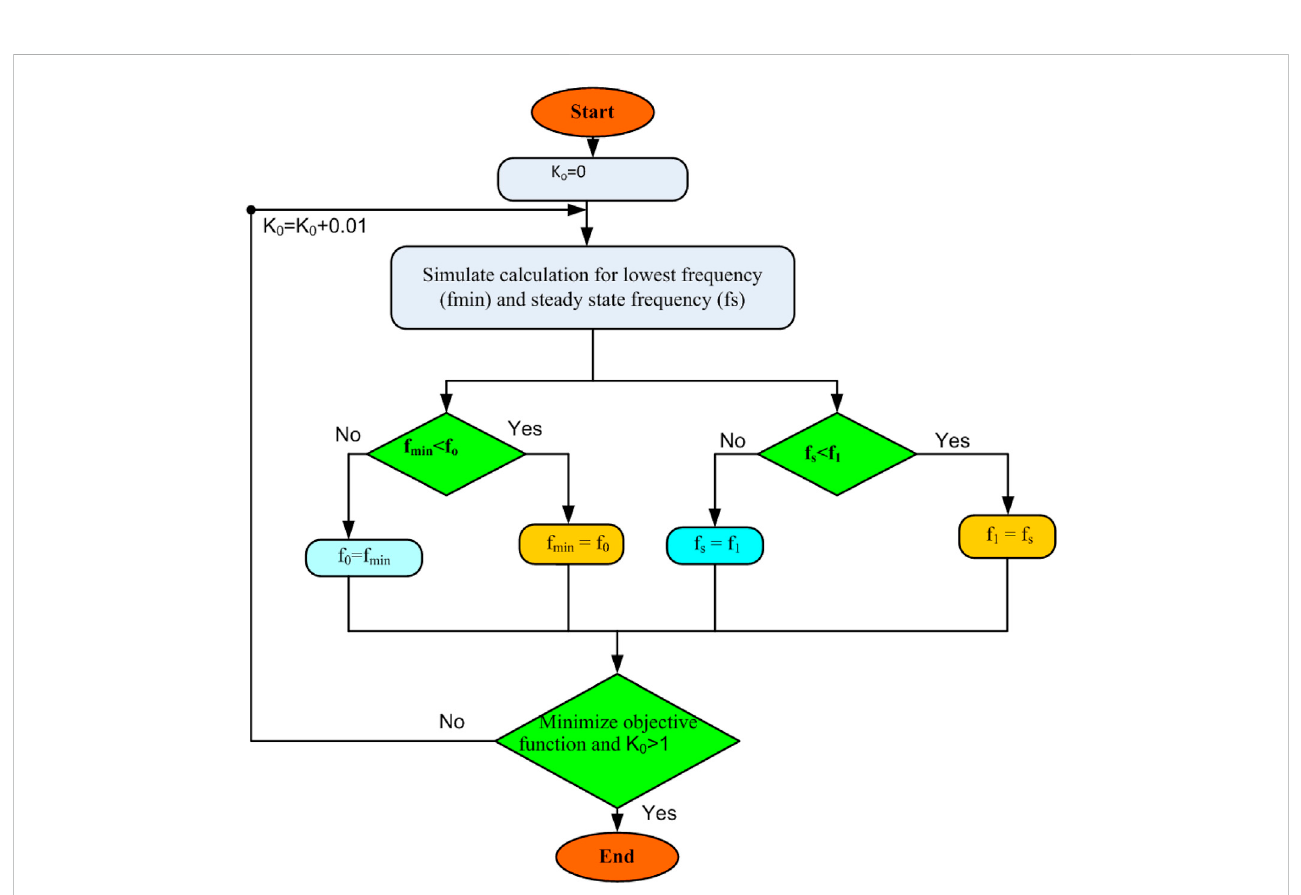
FIGURE 6 Schematic fl ow of parameter optimization for the proposed control